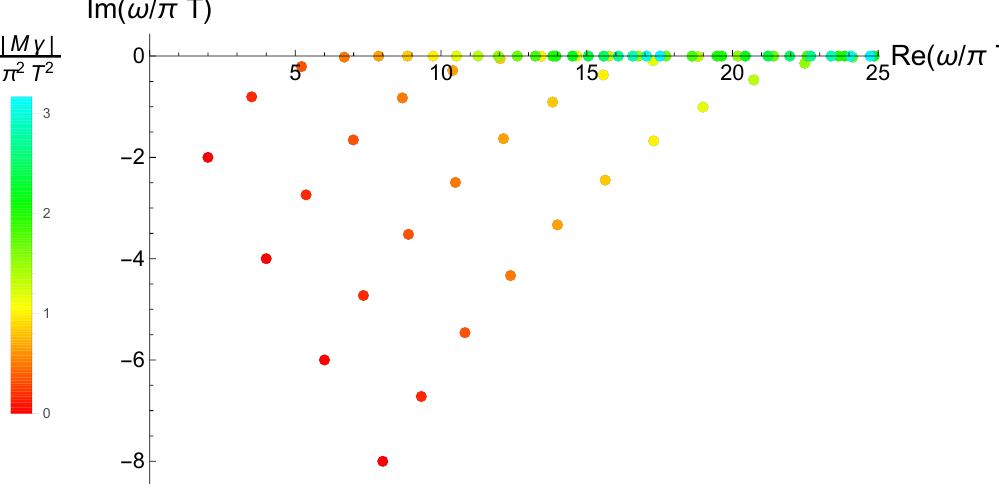
Figure 2 . Quasi normal frequencies for a magnetic black brane in the probe limit. As the magnetic (cid:12)eld increases the quasi normal frequencies drift from their initial value of (cid:10) = !=(cid:25)T = 2 n (1 (cid:0) i ) to the real axis. The values for the quasi normal frequencies were obtained by solving a generalized eigenvalue problem for a discretized version of (3.2) on a Chebyshev grid of size 100. Additional frequencies with a negative real part form a mirror image across the imaginary frequency axis of those depicted in the